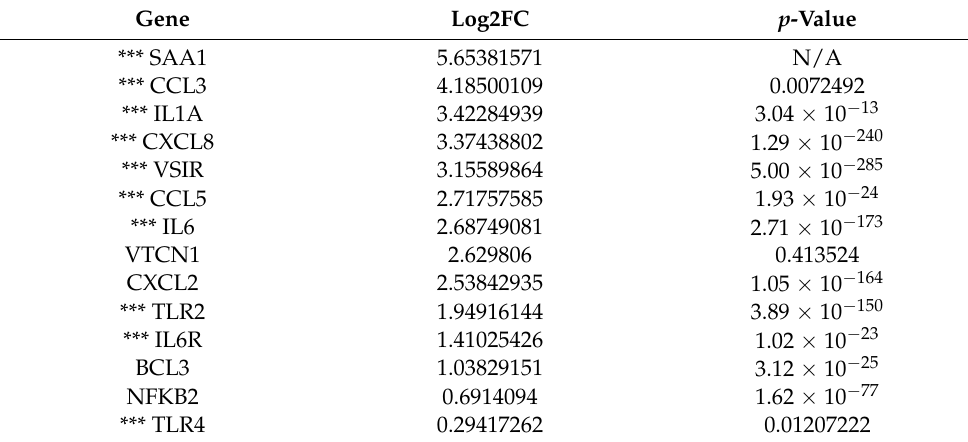
Table 5. Immunomodulators significantly upregulated in MDA MB 231 treated with human visceral adipocyte-conditioned media.